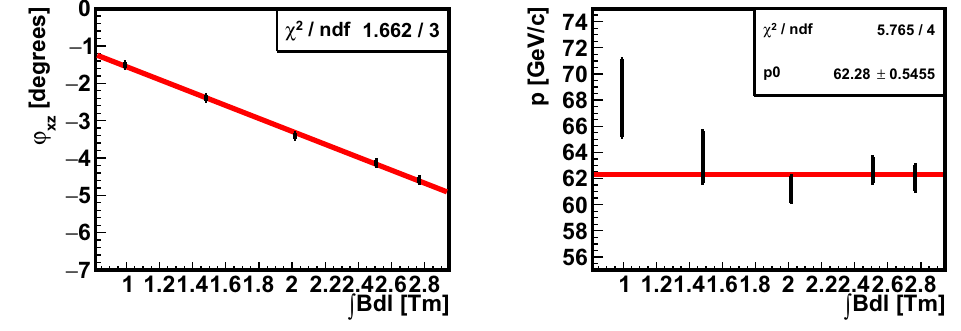
Figure 4. Reconstructed deflection angle of the carbon beam in xz plane (on the left) and reconstructed carbon beam momentum (on the right) as functions of magnetic field integral from a couple of experimental runs with the di ff erent magnetic flux densities B . The linear behaviour observed in the first plot and the constantness of the beam momentum indicated in the second plot are in agreement with the functions (2) and (3), respectively. The final value of the reconstructed carbon beam momentum estimated as constant fit of p vs dependence is thus 62 . 3 ± 0 . 5 GeV / c which is more than three statistical errors lower than nominal value 64.21 GeV / c. This indicates that there is still some source of systematic errors that must be found and eliminated from the